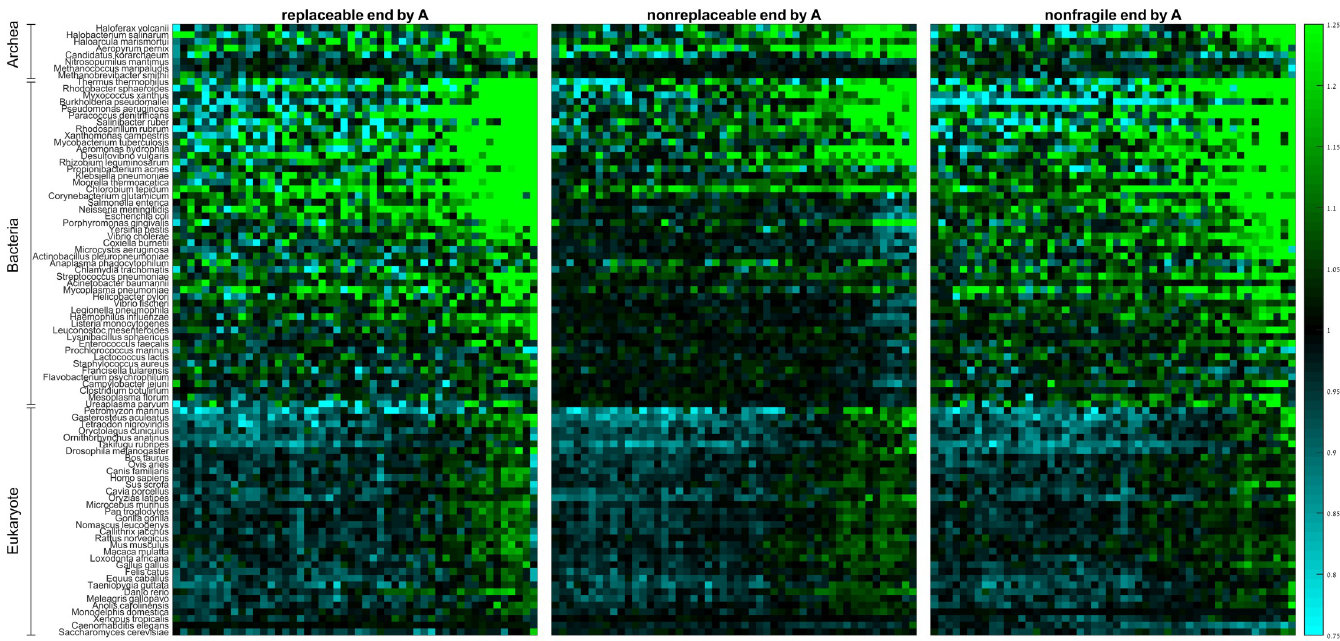
Fig 7. Group RSCA scores of replaceable, non-replaceable, and non-fragile codons that end by A along the last 50 codons of the gene. Rows denote species, columns denote positions. Species within domains are sorted from high (top) to low (bottom)